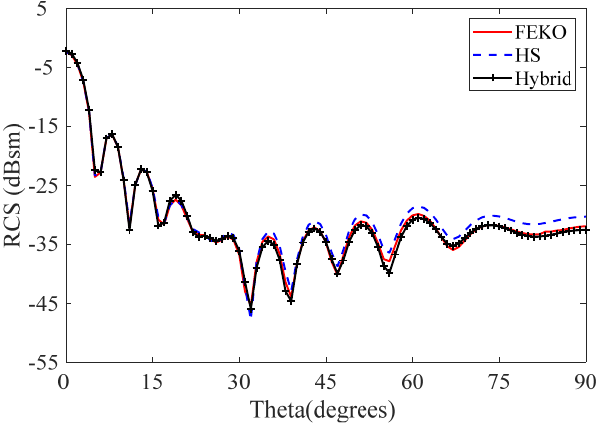
Figure 10. Comparison of VV-polarized monostatic RCS of sandwich structure at frequency of 8 GHz.